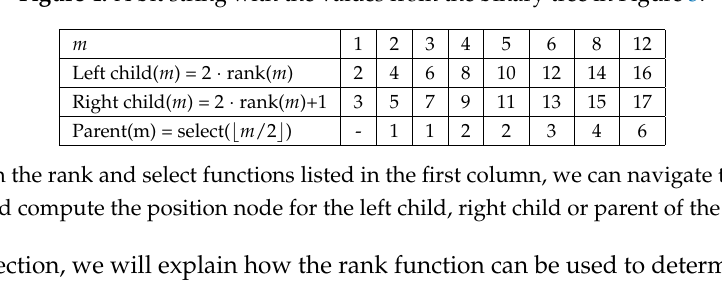
Figure 4. A bit string with the values from the binary tree in Figure 3.